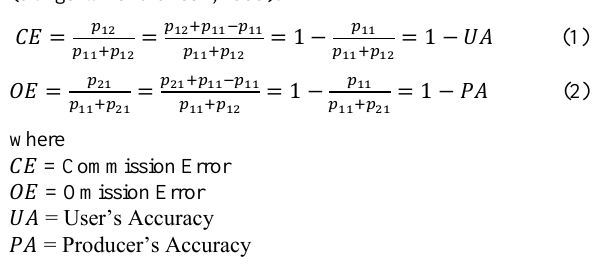
Figure 9. The result of cloud masking. Red colour indicates cloud